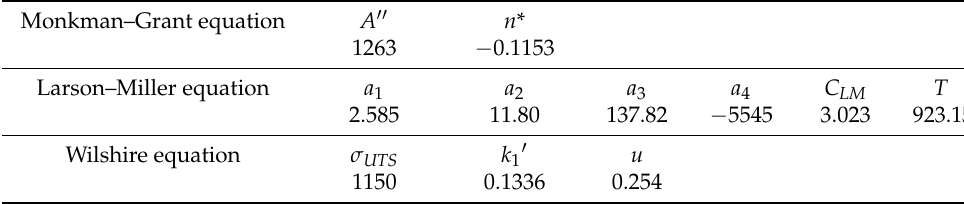
Table 3. Parameter values of the life